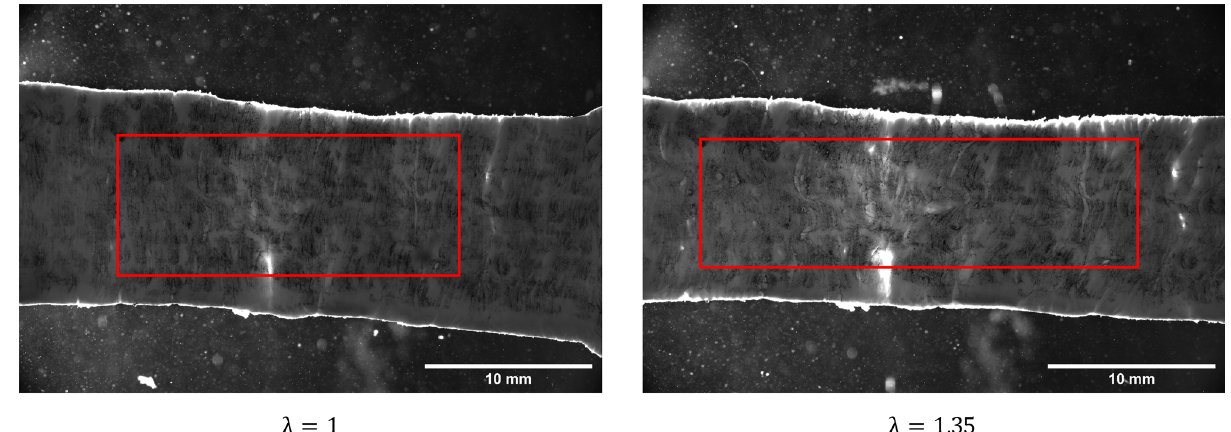
Figure 7. White-light images of the surface used for DIC (opposite to MPI) during the traction of sample 4. Left—prior stretch, (cid:31) = 1 , Right—during stretch, (cid:31) = 1.35 . We observe vertical lines of light grey which open during the traction, that we associate with the separation